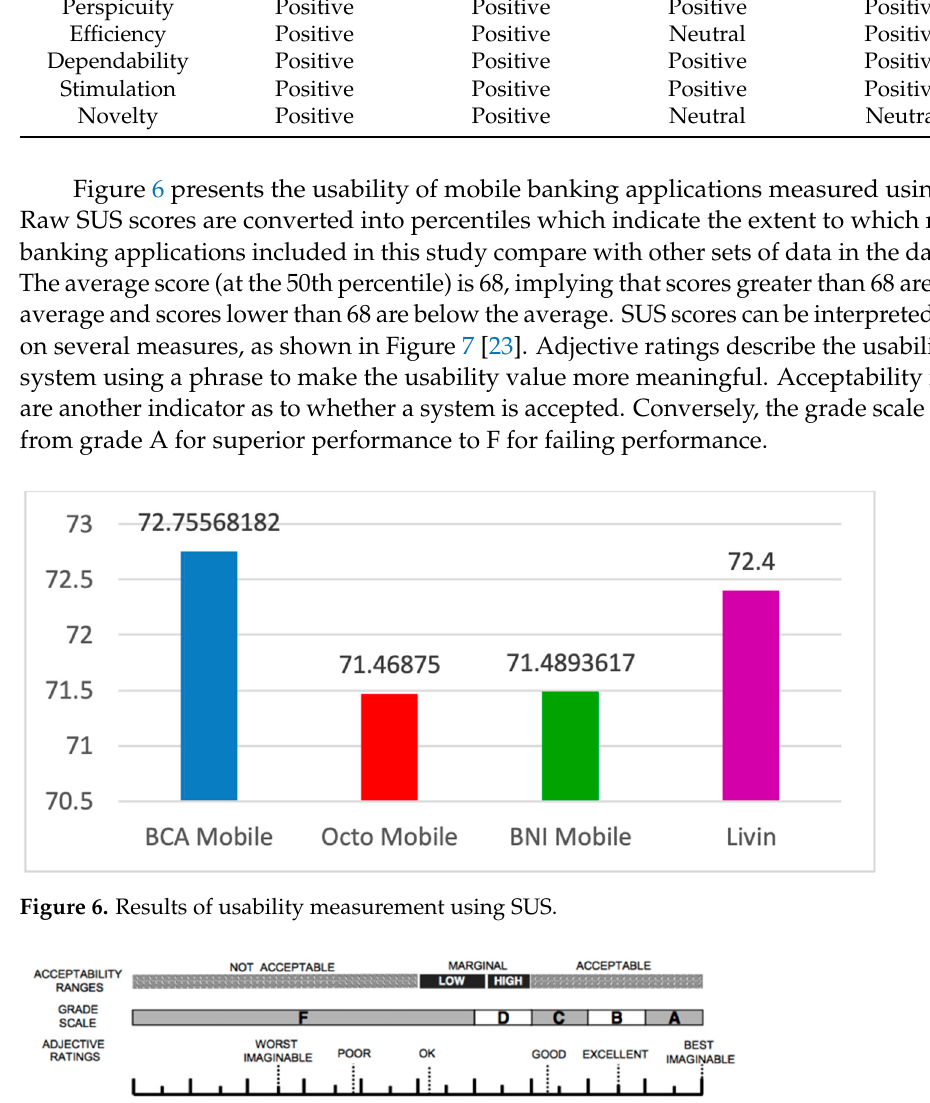
Figure 7. SUS score interpretation.